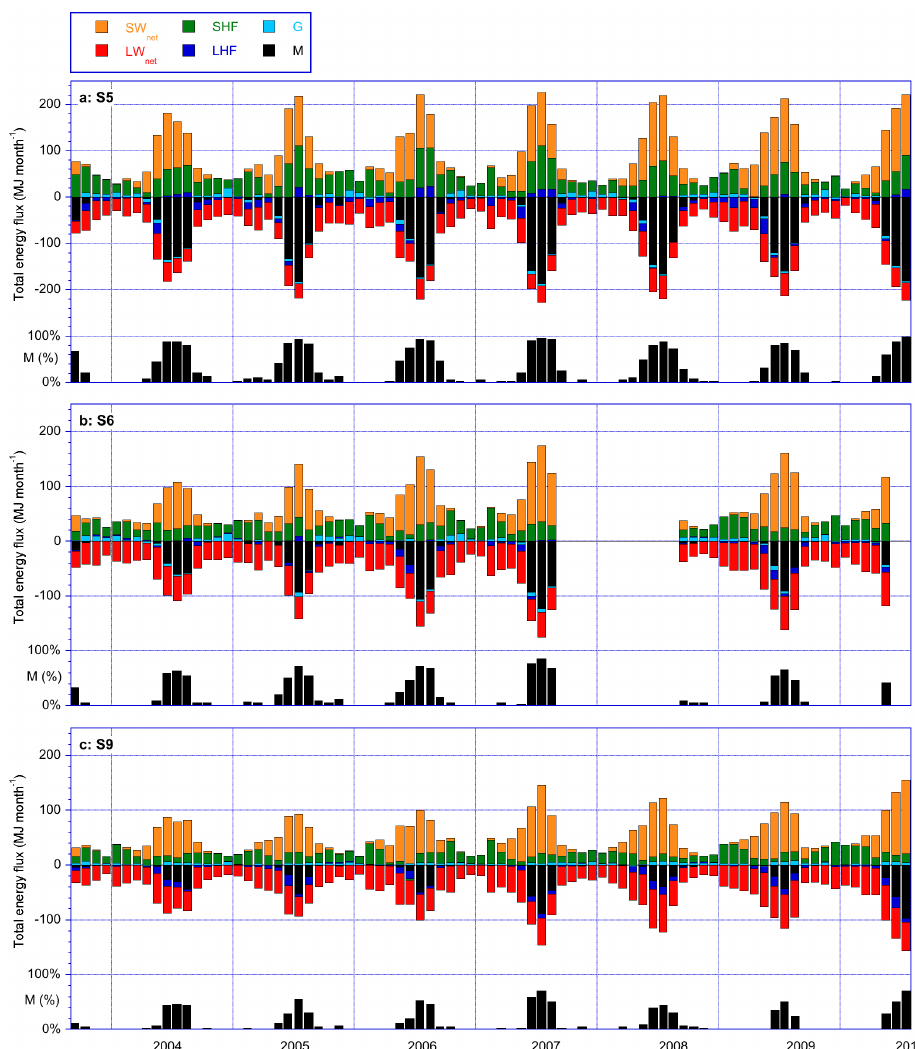
Fig. 8. Monthly mean SEB components and melt frequency (%) at S5 (a) , S6 (b) and S9 (c)